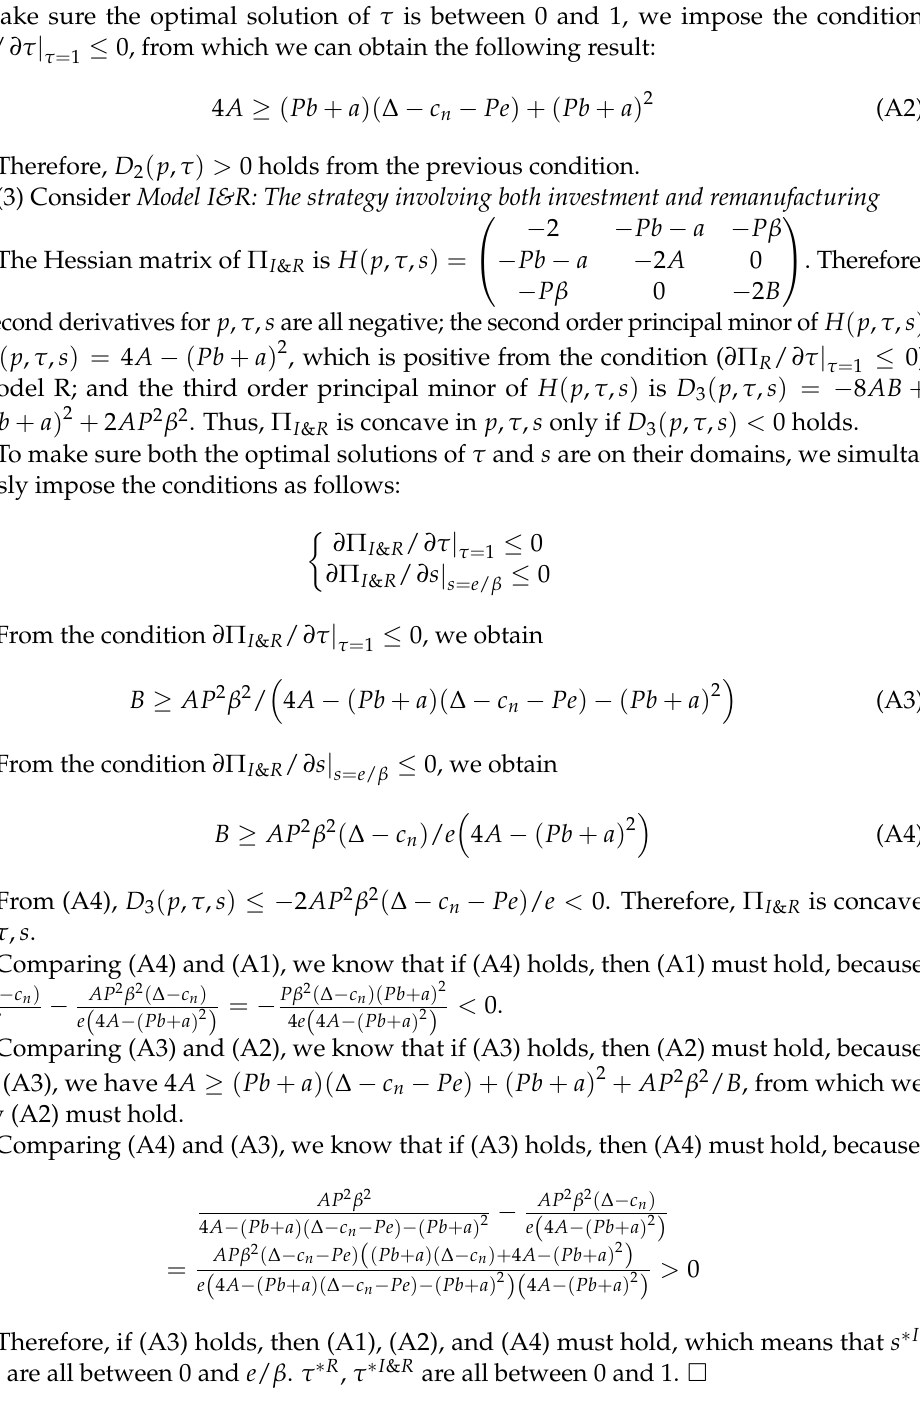
Table A1. Comparison of the manufacturer’s operational models with and without cap-and-trade. Optimal Decisions